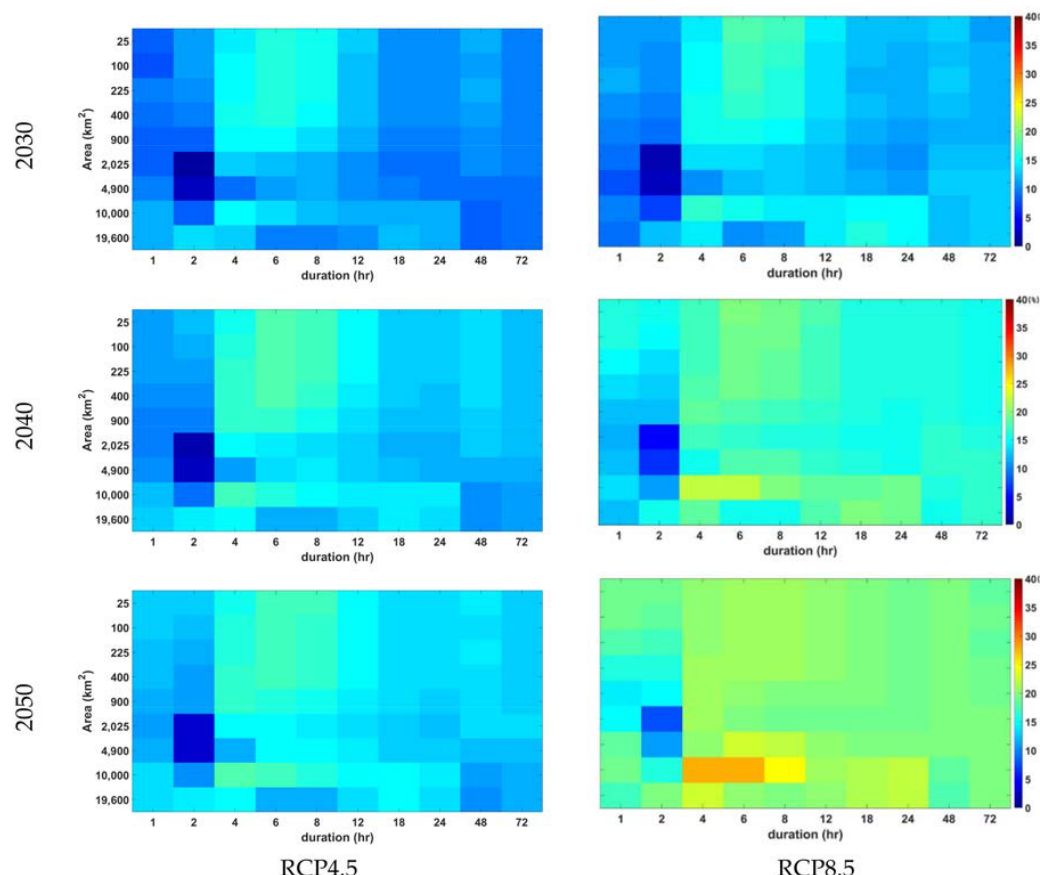
Figure 12. PMPs change rate (%) driven by